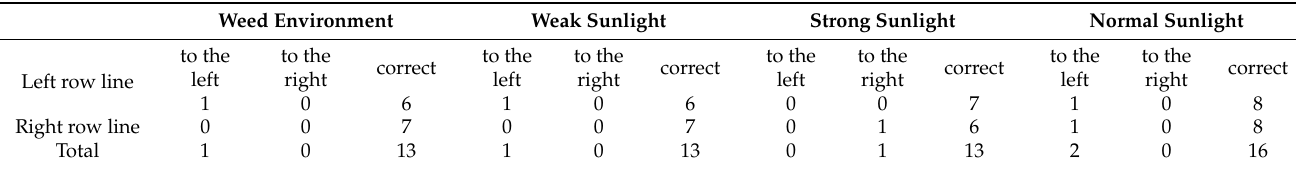
Figure 11. Reference line of a fruit tree row under different sunlight. Table 3. Accuracy of line fitting of the fruit tree